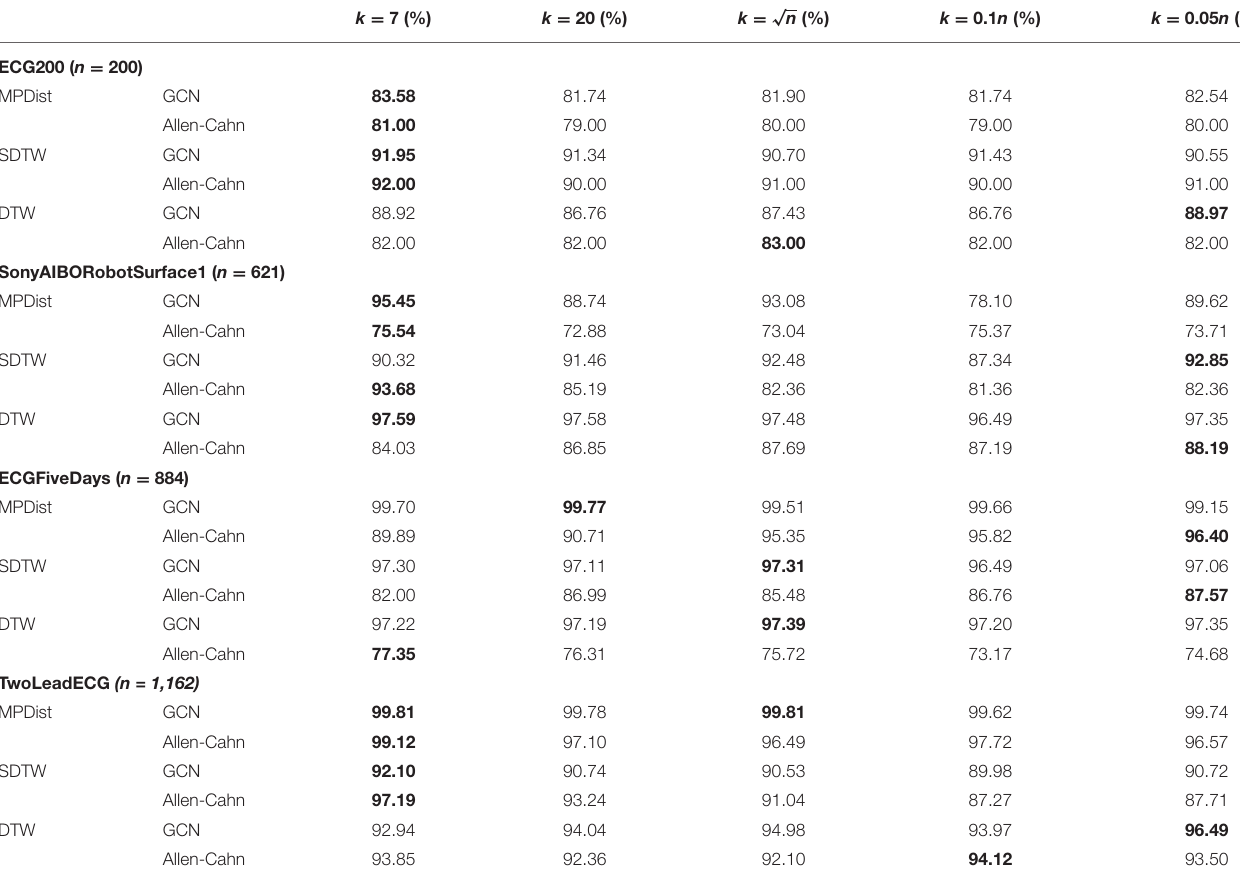
TABLE 3 | Study of self-tuning parameters.